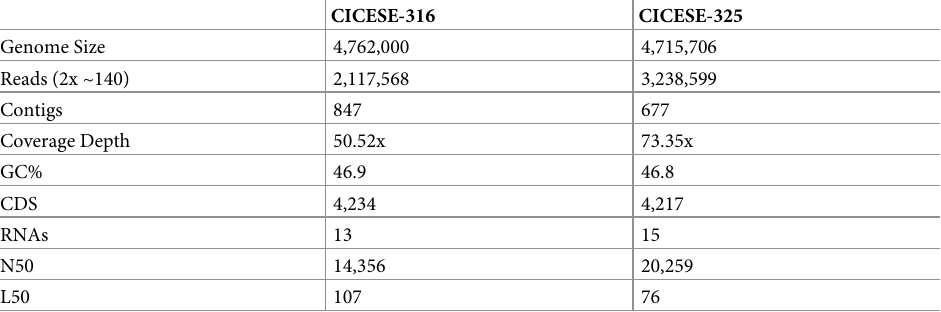
Table 1. Summary of assembly and annotation characteristics of CICESE-316 and CICESE-325 genomes. GC%: Guanine+Cytocine content in chromosomes. CDS: Coding sequences. RNAs: Ribonucleic acids. N50: Minimum con- tig length needed to cover 50% of the genome. L50: Number of contigs whose length sum makes up 50% of the genome